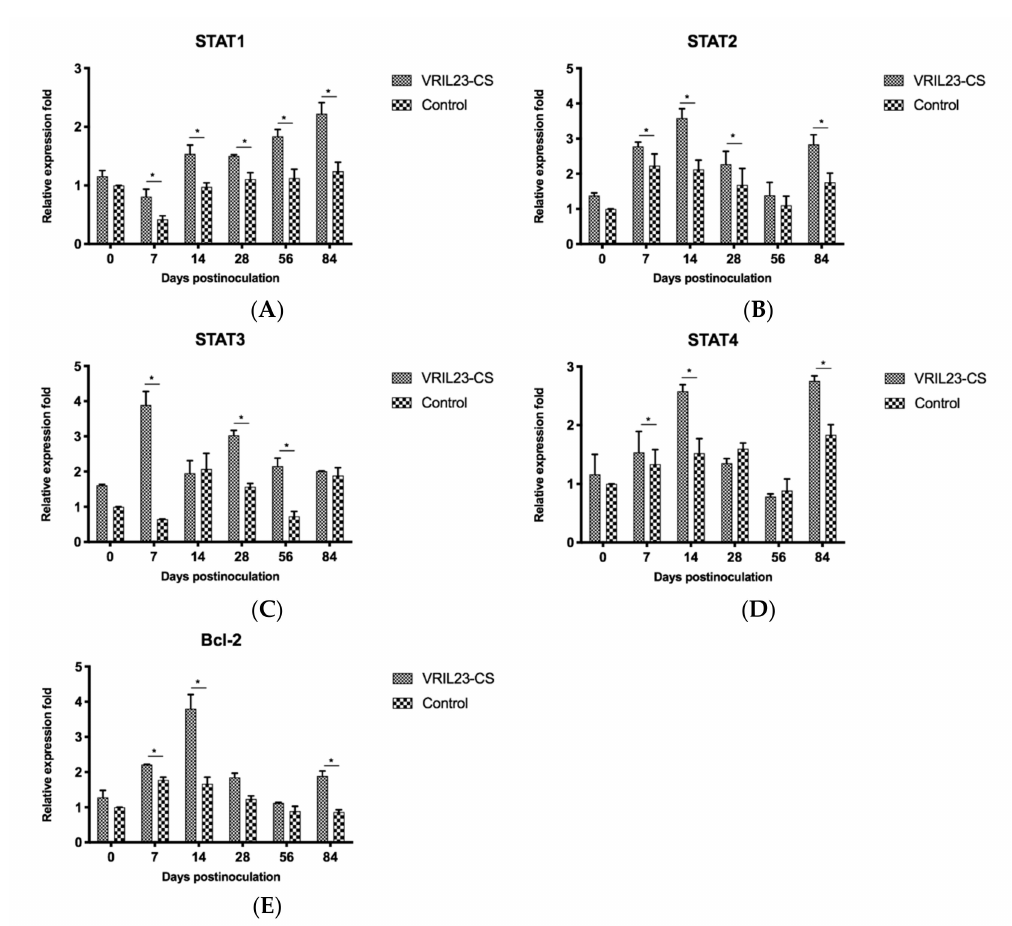
Figure 12. Gene expression levels of immune signal transduction molecules in immune cells of the blood of experimental pigs. ( A ) STAT1; ( B ) STAT2; ( C ) STAT3; ( D ) STAT4; ( E ) Bcl-2. * indicates the di ff erence between the two groups is significant, p <